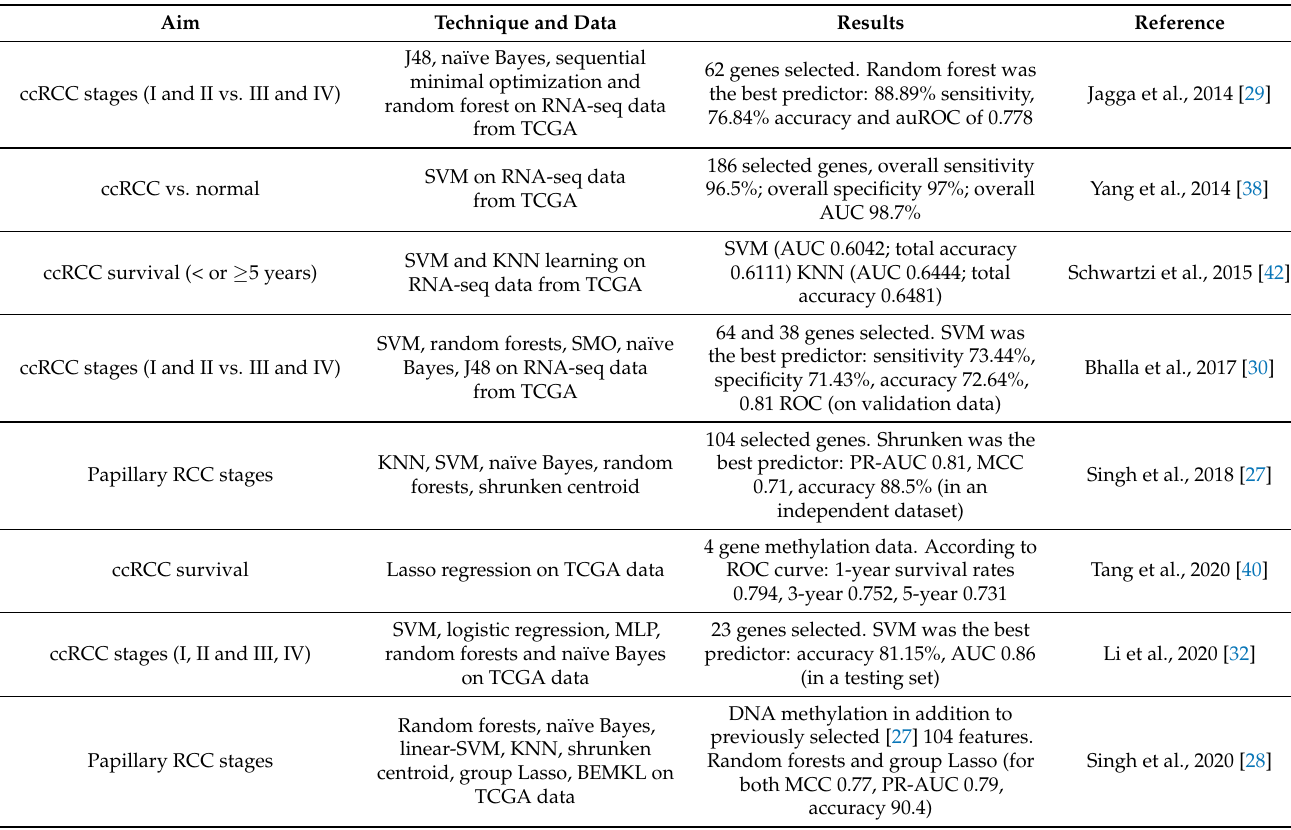
Jagga et al., 2014 [29]